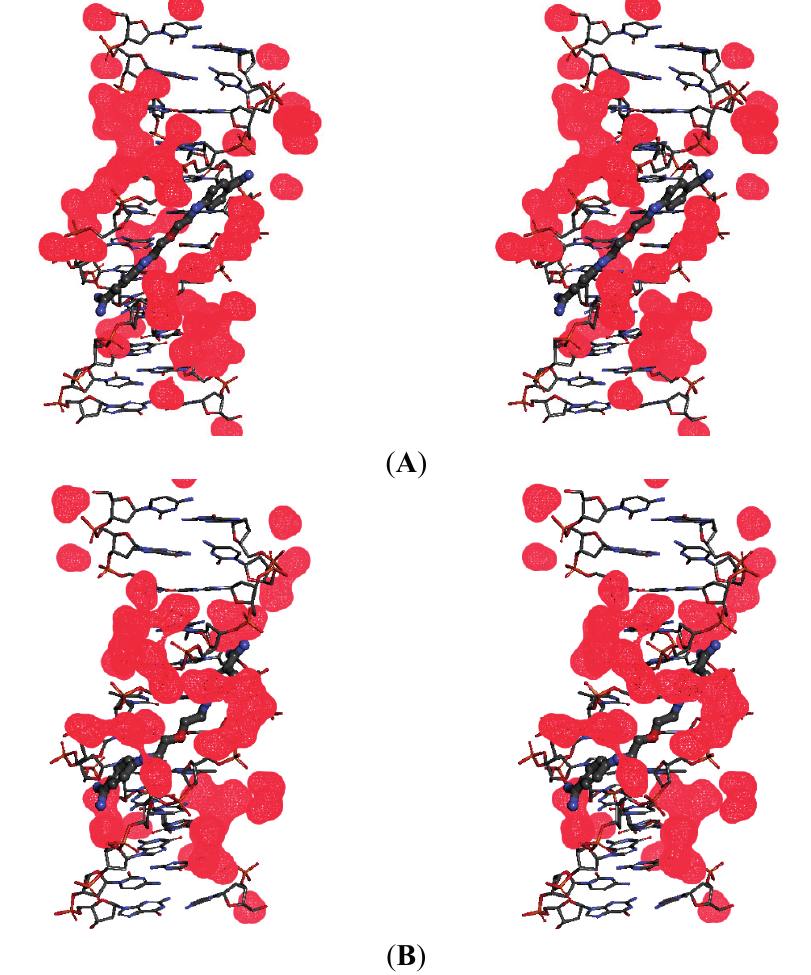
Figure 6. Stereo (cross-eye) views of the hydration surface (water density in red) associated with the movement of compound 5 within the 5'-(CGCGAATTCGCG) 2 -3' dodecamer. ( A ) In the time frames between 1.5 and 2 ns MD–there are no direct H-bond contacts between the DNA bases and both amidinium groups; ( B ) In the time frames between 5 and 10 ns MD–both amidinium groups in ligand make direct H-bond contacts with the DNA